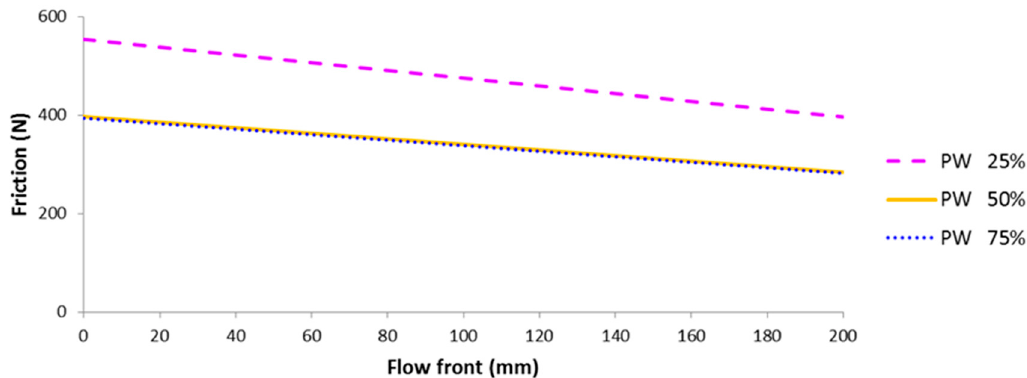
Figure 8. Predicted friction force with respect to flow front position in the multi-layered preform with various ratios of PW to UD carbon fabric.